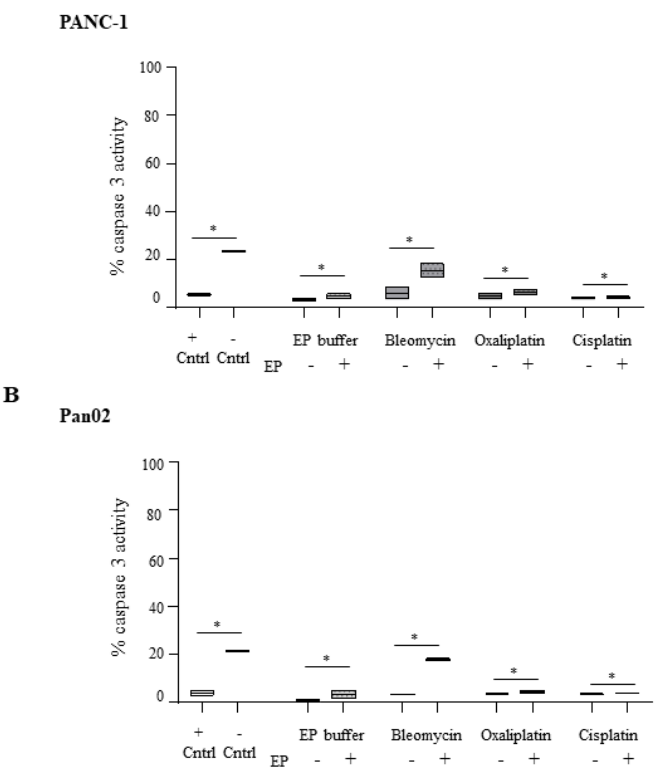
Figure 3. Caspase-3 is activated upon Bleomycin but not platinum drug-based electrochemotherapy in pancreatic cancer cells. PANC-1 ( A ) and Pan02 ( B ) cells were electroporated in the presence or absence of Bleomycin, Cisplatin or Oxaliplatin and subsequently reseeded in 6 wells plates at a density of 0.5 × 10 6 cells / mL for PANC-1 or 125 × 10 3 cells / mL for Pan02 in a total volume of 2 mL. For PANC-1 cells, Bleomycin was used at a concentration of 0.1 µ g / mL, Cisplatin at 0.1 µ g / mL and Oxaliplatin at 3 µ g / mL. For Pan02 cells, Bleomycin was used at a concentration of 0.1 µ g / mL; Cisplatin at 0.5 µ g / mL and Oxaliplatin at 1 µ g / mL. 24 h later, intracellular staining of cleaved caspase-3 was performed, and cells analyzed using flow cytometry. OE21 cells were left untreated (negative control) or treated with 30 µ M 5-FU for 24 h as a positive control for active caspase-3 activity. The data (minimum to maximum) is also presented as floating bar graphs—with the median integrated intensity relative to EP bu ff er alone denoted with a line. * statistically significant di ff erences in percentage active caspase activity between the conditions highlighted, * p = 0.05.